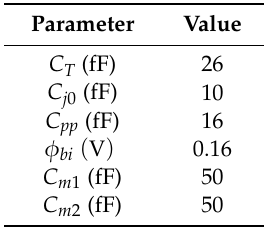
Table 2. Value of parameters of Equation (2).